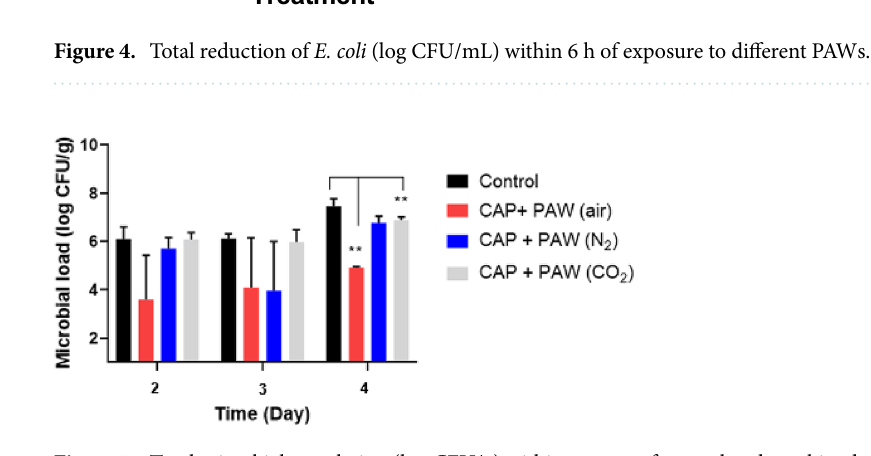
Figure 5. Total microbial population (log CFU/g) within sprouts of control and combined plasma treatments measured over 4 days of growth in plant chambers set at 25 °C ± 1 °C in the dark at 45% humidity level. **P ≤